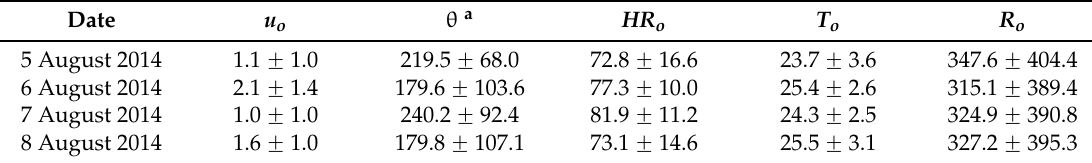
Table 1. Daily climatic condition values: u o , outside wind velocity (m ¨ s ´ 1 ); θ , wind direction ( ˝ ); HR o , outside relative air humidity (%); T o , outside air temperature ( ˝ C); R o , incoming shortwave